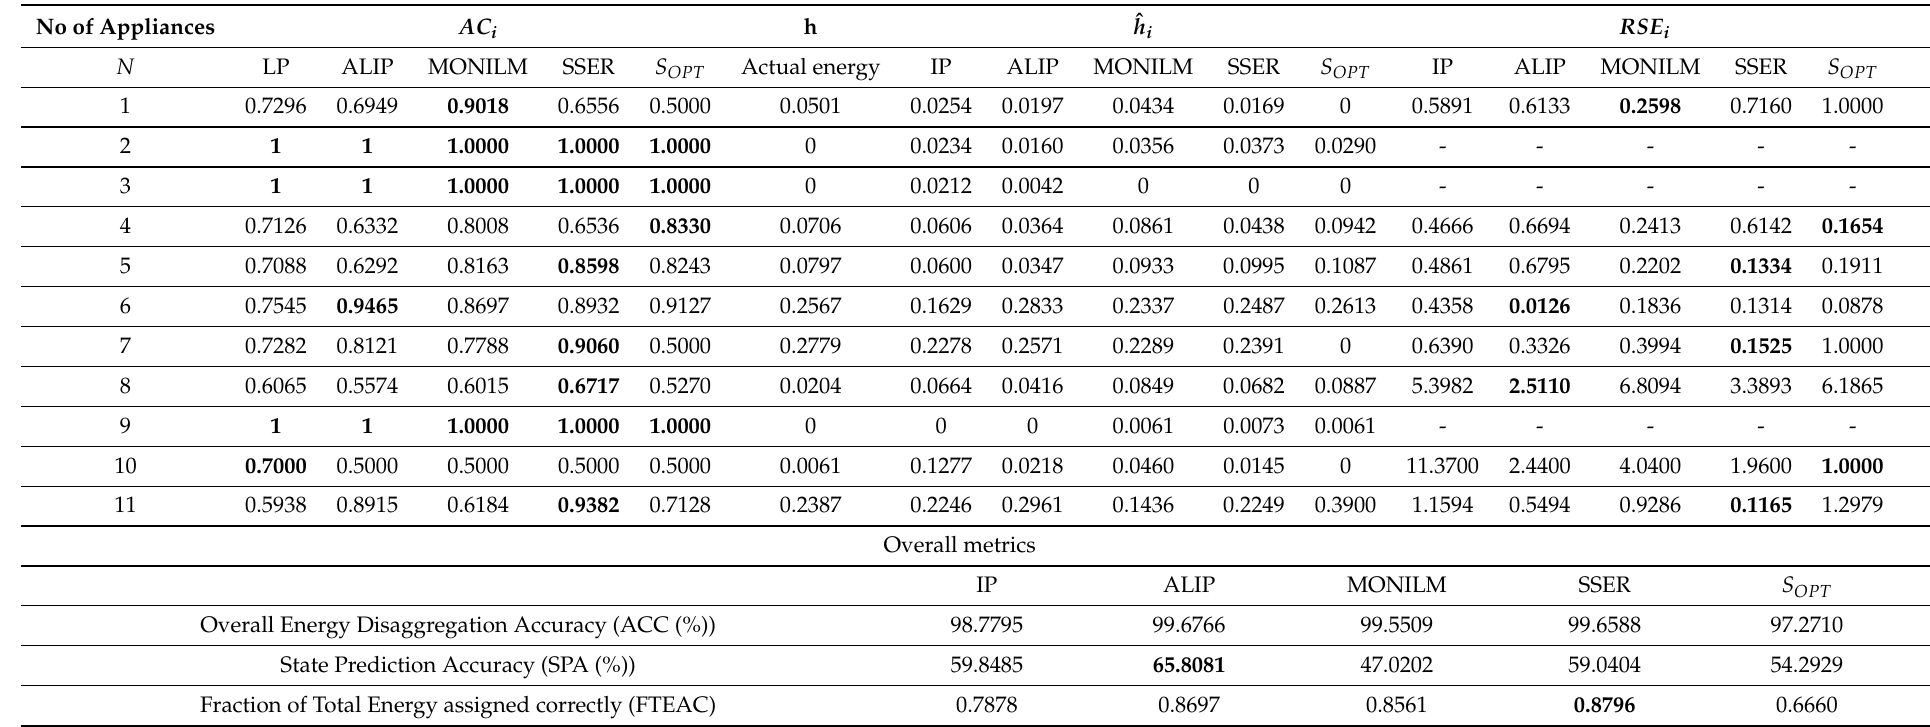
Table 6. Baseline results for instance I 12